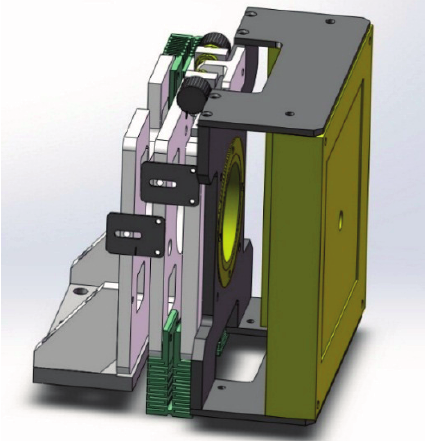
Figure 6. Design of the adjusting mechanism to adjust the location of the